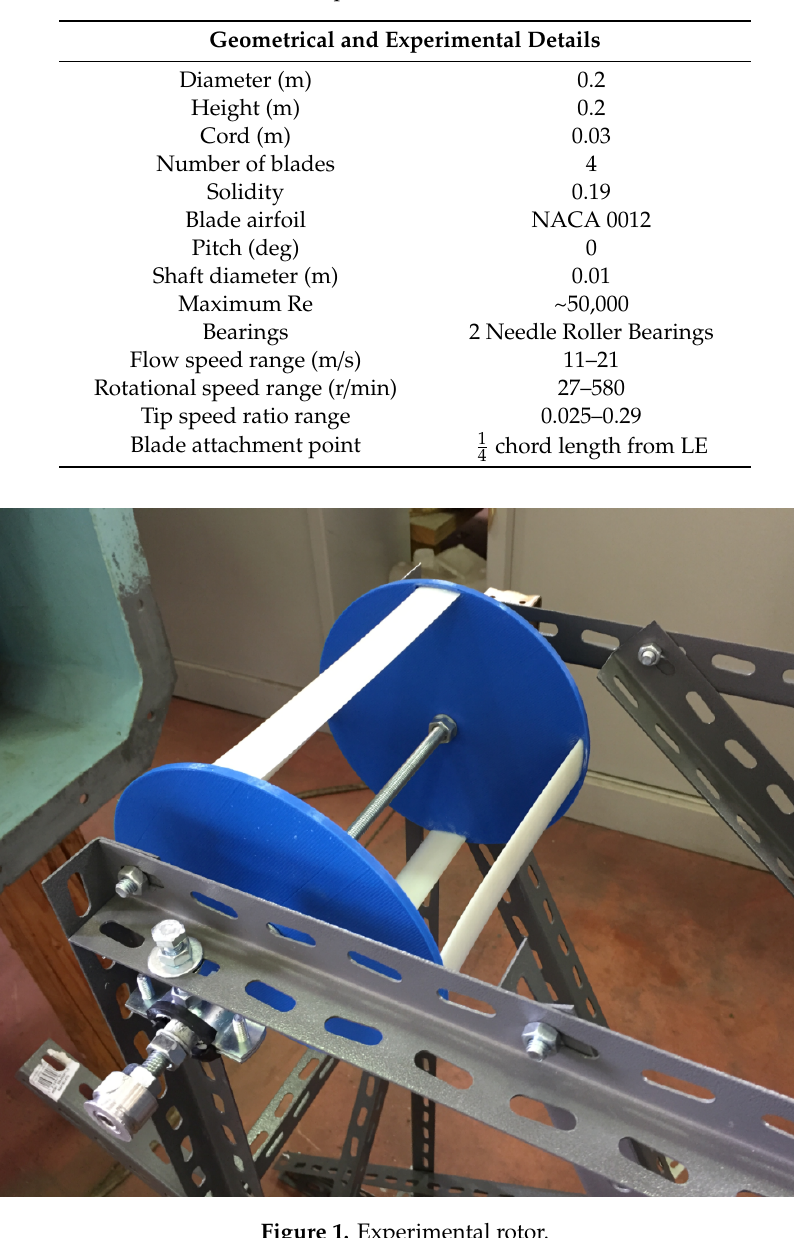
Table 1. Experimental rotor features.